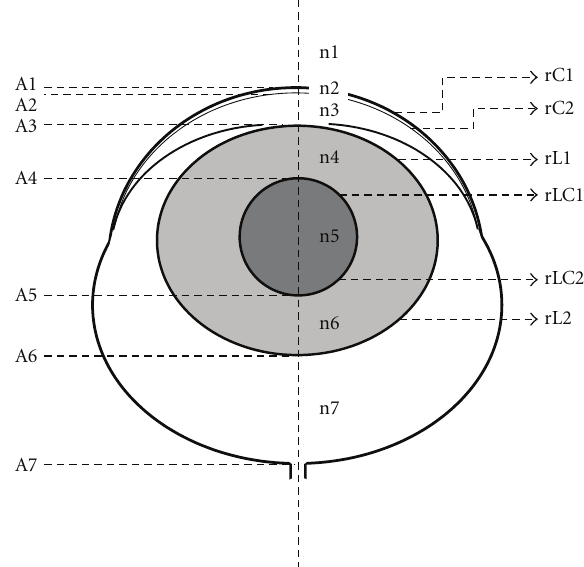
Figure 3: Schematic rat eye model with main parameters needed for refractive state estimation (see Table 1). A1 (corneal surface) through A7 (vitreoretinal border) are distances along the horizontal dashed line; 130 μ m was added to A7 to approximately account for the postreceptor retina contribution. If A1 is set to 0 mm from corneal surface and numbers increase from top to bottom, then rC1, rC2, rL1, and rLC1 are positive, while rLC2 and rL2 are